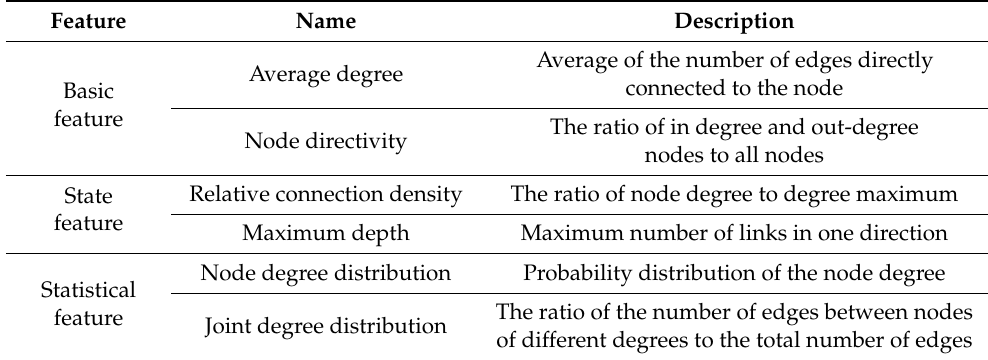
Table 2. Description of the original TIAG